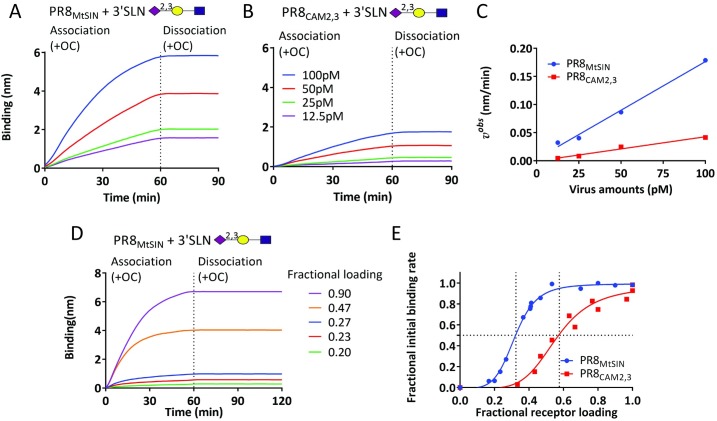
Determination of IAV binding rates by BLI.SA sensors were fully loaded with biotinylated Neu5Acα2-3Galβ1-4GlcNAcβ-Sp8 (3’SLN). PR8MtSIN (A) and PR8CAM2,3 (B) were bound (12.5 pM to 100 pM, corresponding to 0.75E+09 to 6E+09 particles in 100 μl; S7 Fig) in the presence of 10 μM OC. After 60 minutes sensors were washed (PBS, 3 times) and virus dissociation in PBS was recorded for 30 minutes. (C) vobs of both viruses was plotted against virus concentration. The resulting linear curves (P<0.001 as determined by IBM SPSS statistic 24) as well as vobs normalized for particle number (mean ± SD]; 0.19285 ± 0.044309 for PR8MtSIN and 0.03985 ± 0.007378 nm/min per 100pM virus particles for PR8CAM2,3; P = 0.0005) differed significantly. (D) 3’SLN receptor was loaded to a range of densities and allowed to bind to 100 pM virus (PR8MtSIN) in the presence of OC. After 60 minutes sensors were washed (PBS, 3 times) and virus dissociation in PBS was recorded for 60 minutes. (E) The vobs was calculated for all binding curves of PR8MtSIN and PR8CAM2,3 (shown in S4 Fig) and plotted as fractional binding rate (y-axis) against fractional receptor loading density (x-axis).